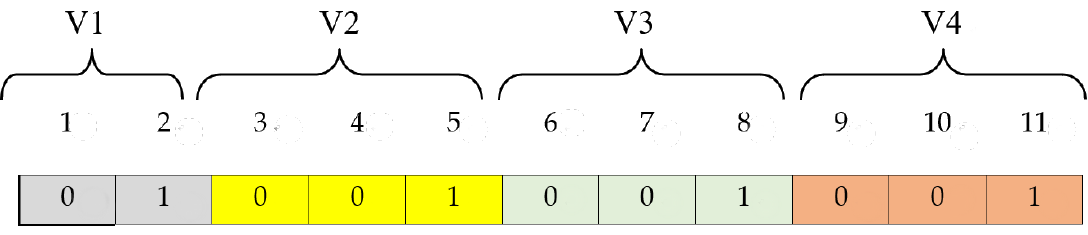
Figure 6. The encoding scheme for the features in an antibody.